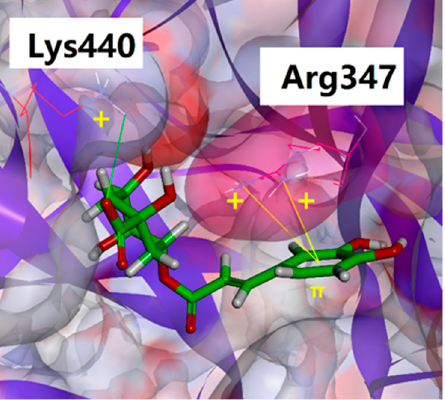
Figure 6. The detail interaction between chlorogenic acid and Arg347/Lys440.